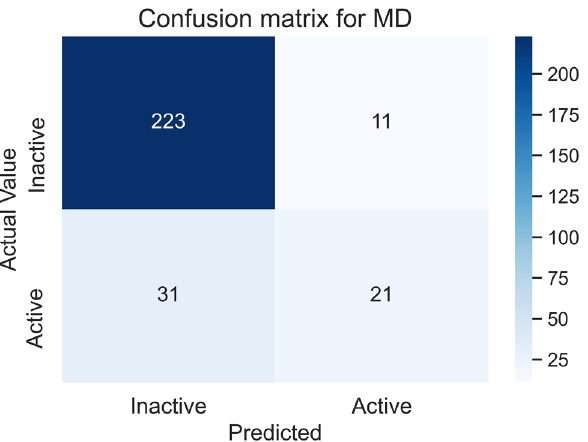
Figure 3. The confusion matrix was obtained from the performance of the MD model on the test set. The test set had a total of 286 compounds, of which 52 were active and 234 were